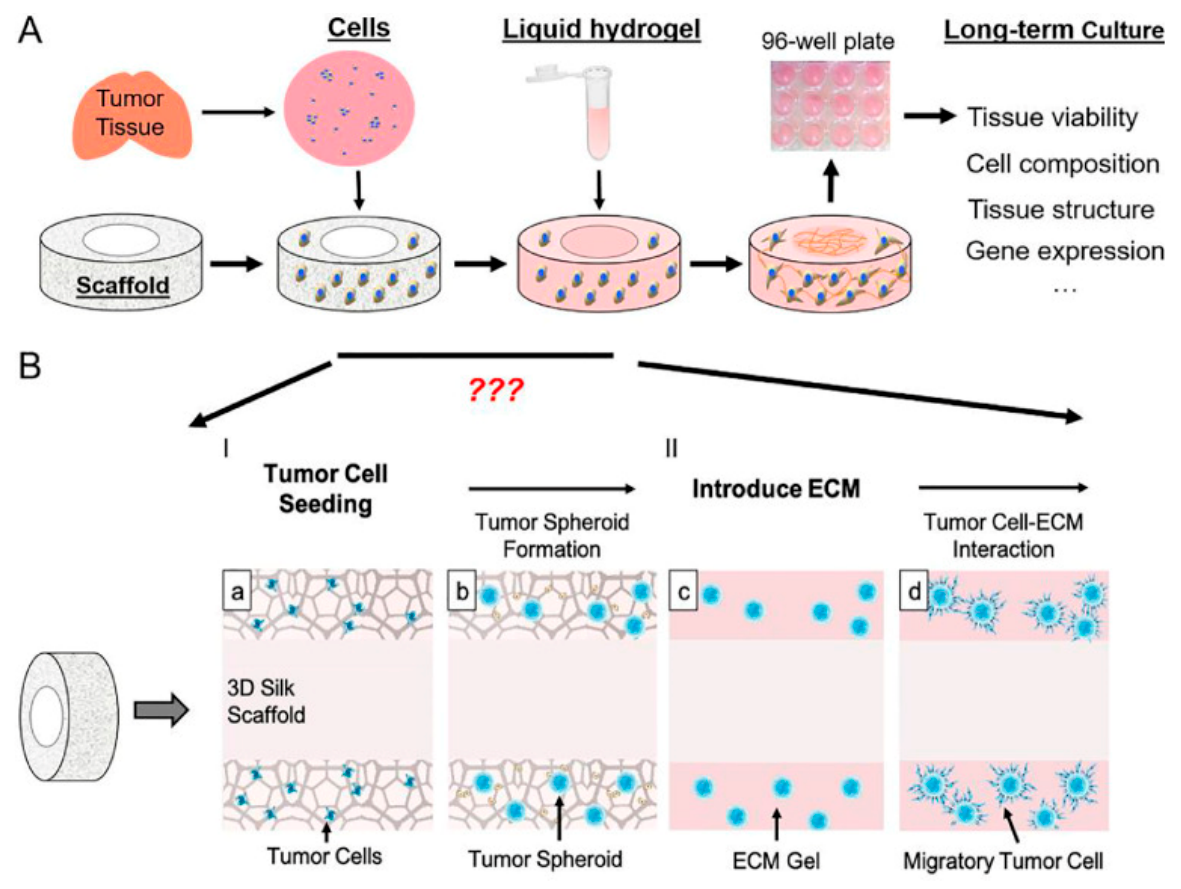
Figure 3. Schematics of the 3D modeling process: ( A ) Schematics of the 3D brain tissue engineering process. ( B ) To adapt the process for brain tumor model, questions regarding media conditions,